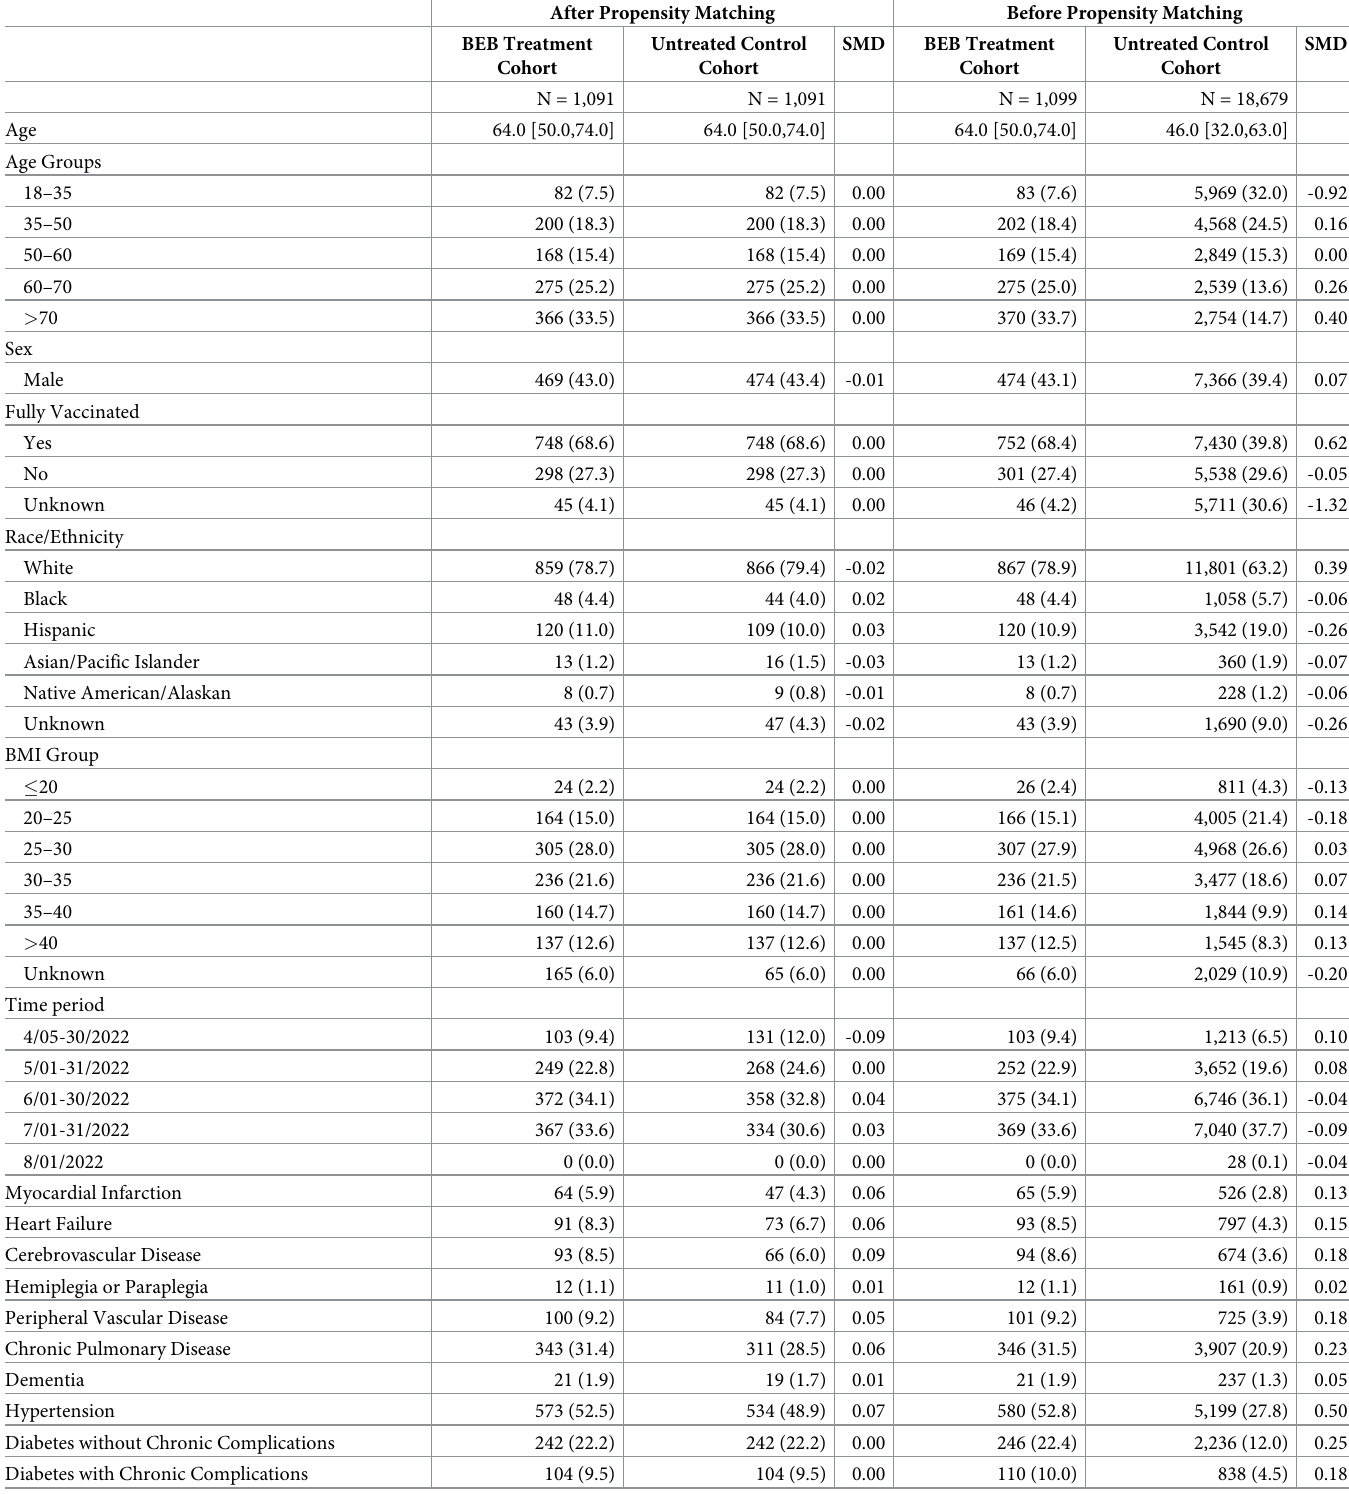
Table 1. Patient characteristics and covariate balance before and after propensity matching. After Propensity Matching Before Propensity